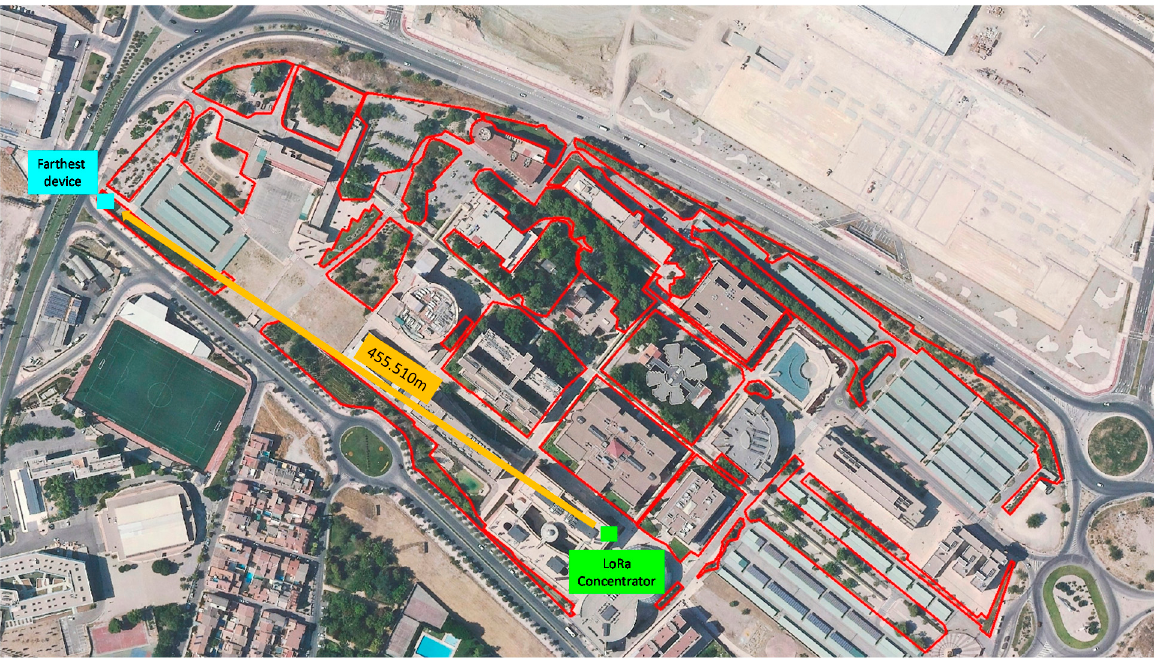
Figure 18. Flow chart of the change parameters routine for the ECDL.